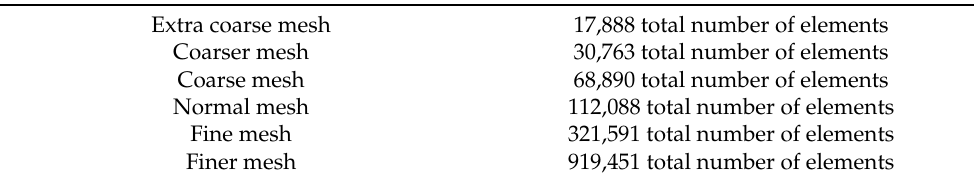
Table 2. Mesh information for a different level of meshing.